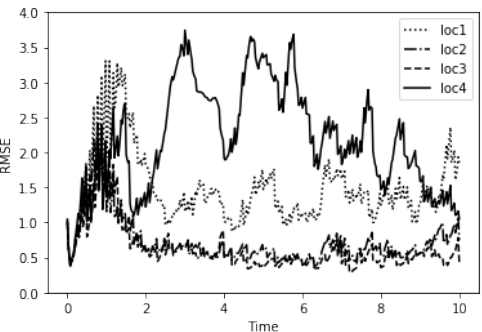
Figure 2. The RMSE of the ensemble mean analysis averaged over the points for different localization radii. Loc1, loc2, loc3, and loc4 represent 0.05, 2, 4, and 6 localization scales,